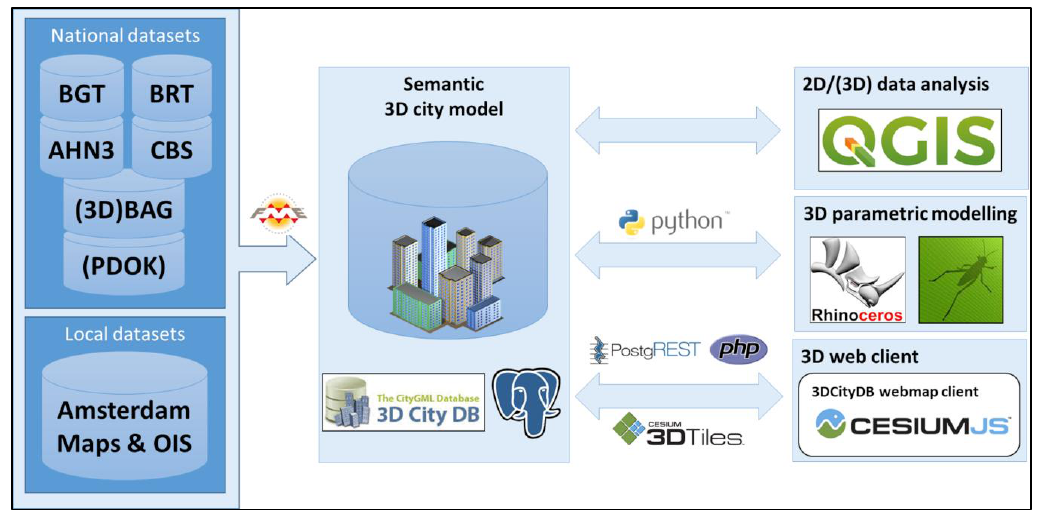
Figure 11. Overview of the datasets and technologies used to implement the methodology presented in Section 2, and associated data flows. The acronyms of the datasets are explained in Section